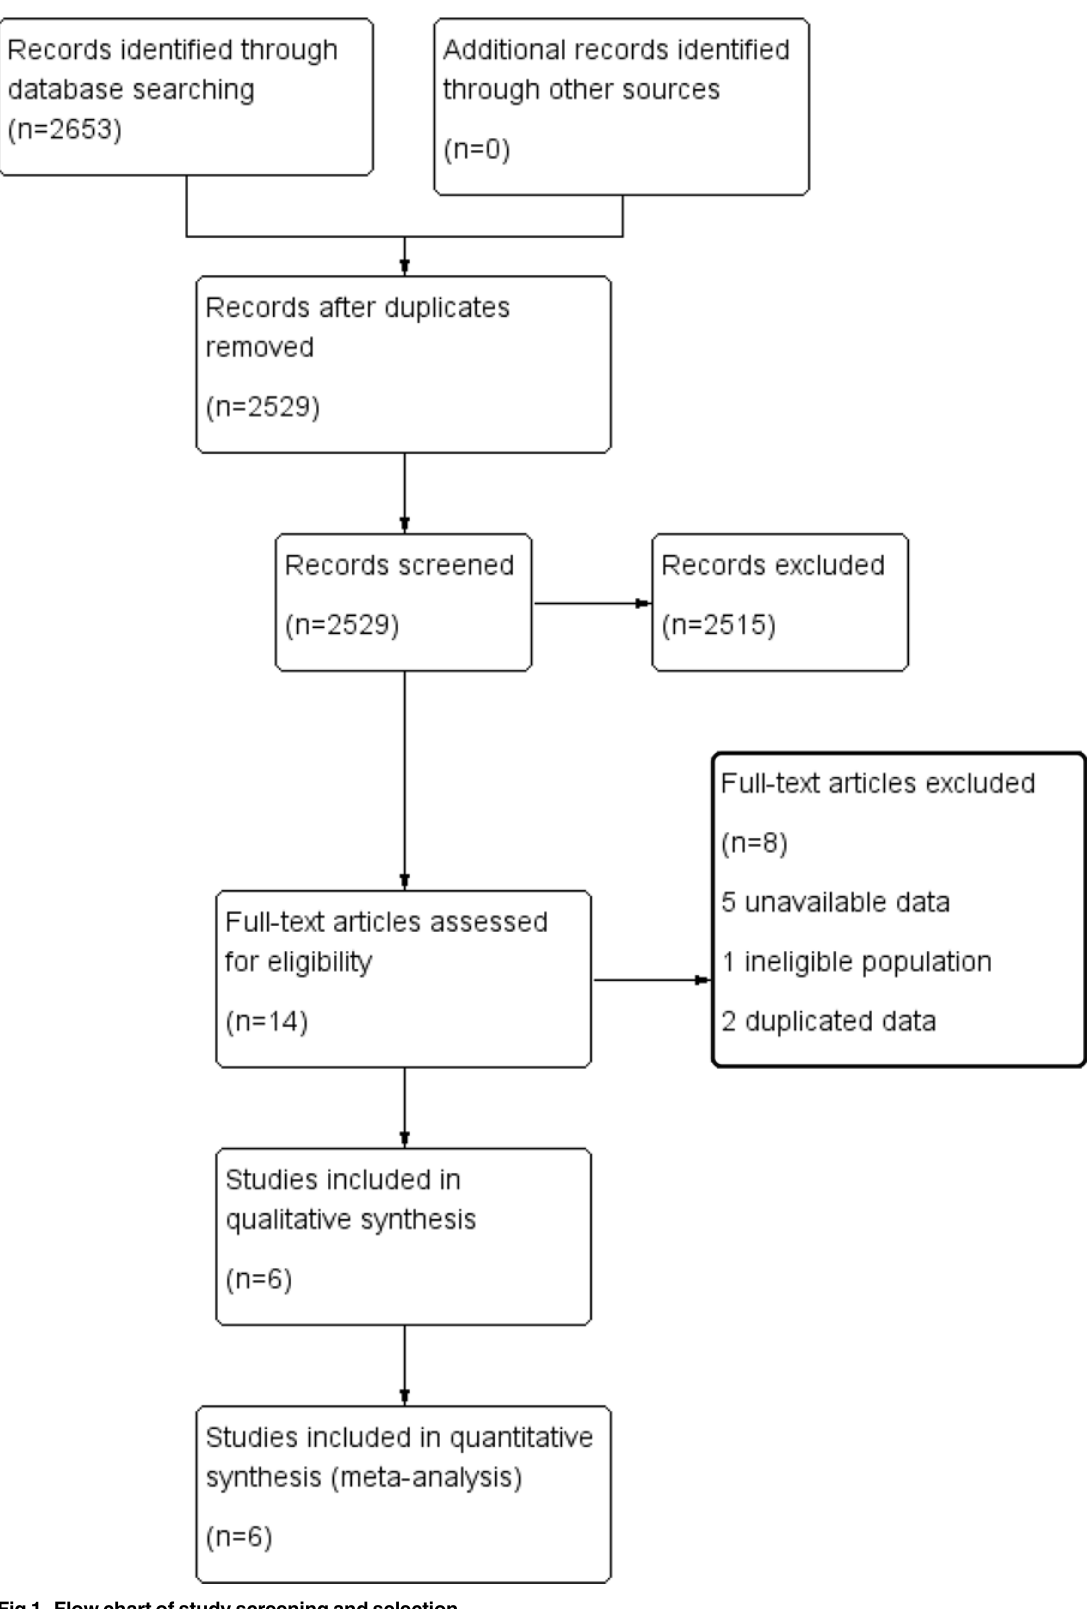
Fig 1. Flow chart of study screening and selection. doi:10.1371/journal.pone.0144774.g001 PLOS ONE | DOI:10.1371/journal.pone.0144774 December 10,